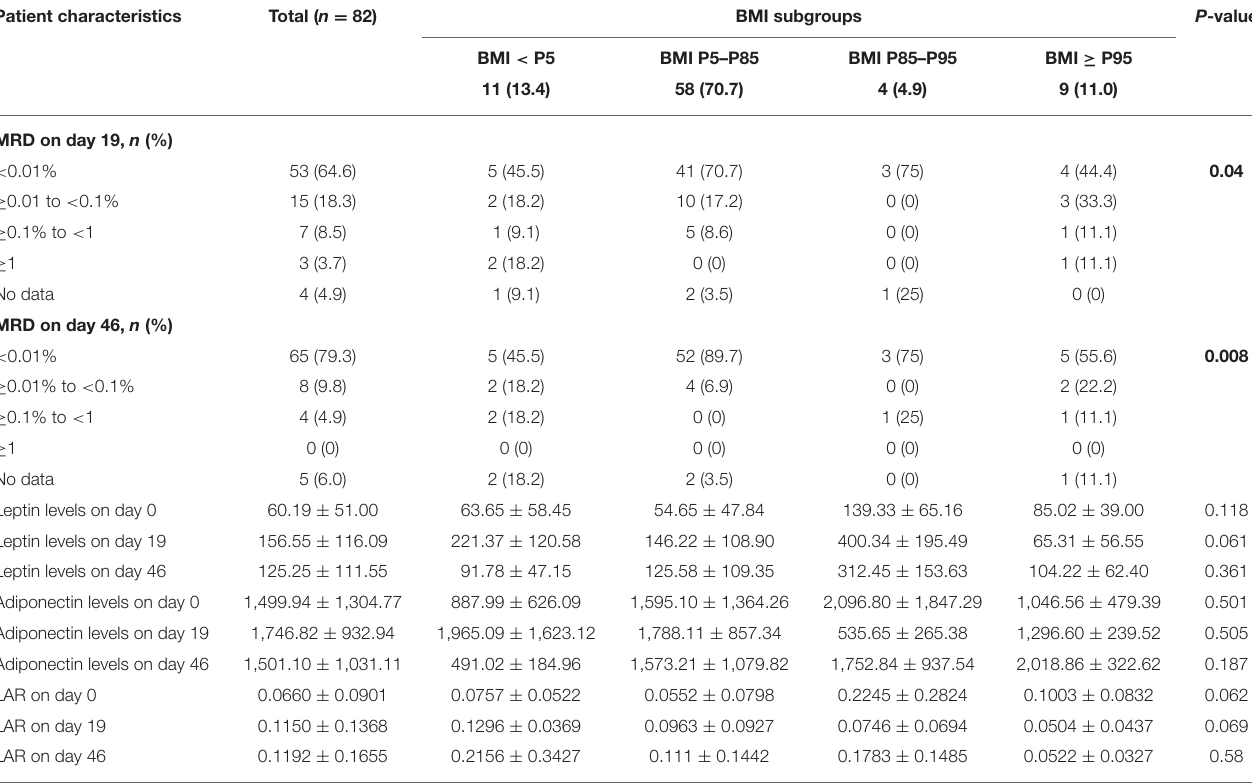
TABLE 4 | Patient minimal residual disease and adipocytokine levels based on body mass index. Patient characteristics